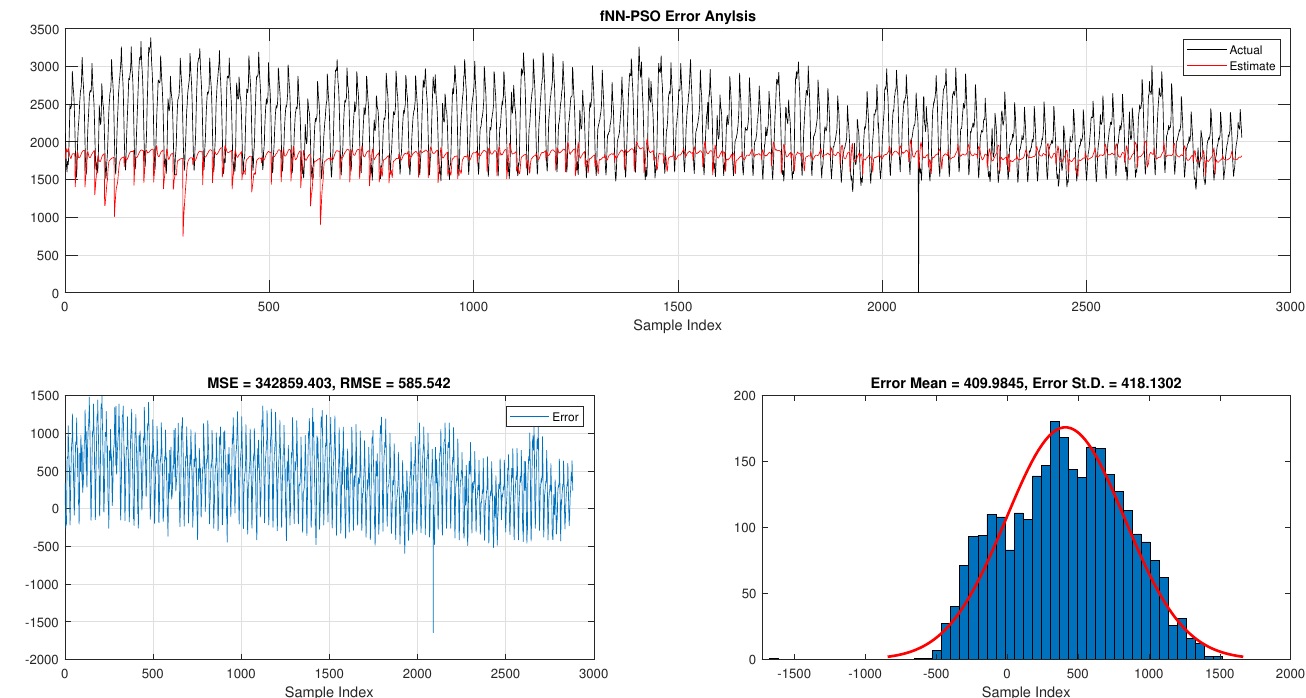
Figure 11. Error analysis of the hourly daily load consumption with fNN-PSO best results.